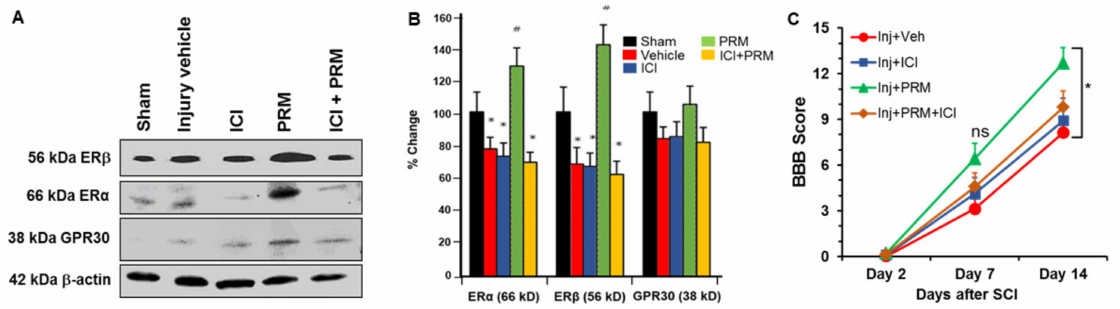
Figure 9. PRM treatment for 7 days increased expression of E2 receptors following SCI and promoted improved motor function in SCI. PRM treatment increased the expression of E2 Receptors, Er α and Er β , following SCI as shown by Western blotting ( A ), and densitometric analysis of protein bands ( B ). In contrast, PRM did not significantly alter the levels of GPR30, a different E2 receptor ( A , B ), suggesting the increased expression of Er α and Er β receptors is generated by PRM treatment. The increase in the levels of ER receptors was reversed by the addition of ER antagonist (ICI), further indicating that the neuroprotective action of PRM is based on their specificity to both E2 receptors. n = 10. * p < 0.05 compared to sham animals, and # p < 0.05 compared to vehicle treated SCI animals. ( C ) BBB score was determined for SCI rats treated with vehicle control, ICI control, PRM, and PRM + ICI as described in the methods. Rats were graded weekly using the BBB scale to examine motor function after SCI. PRM treated rats showed significantly higher BBB scores compared to controls or ER inhibitor (ICI) at day 14. * p < 0.05, ns = not